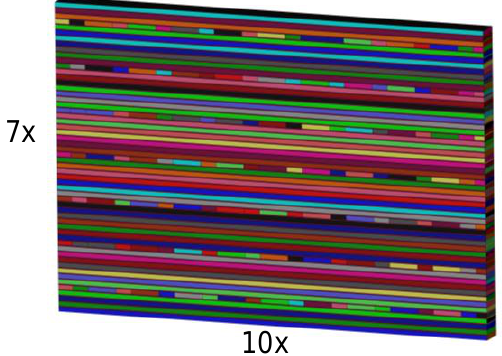
Fig. 7. Geometry of the overall porous heat exchanger model with sensors in a 10x7 matrix.